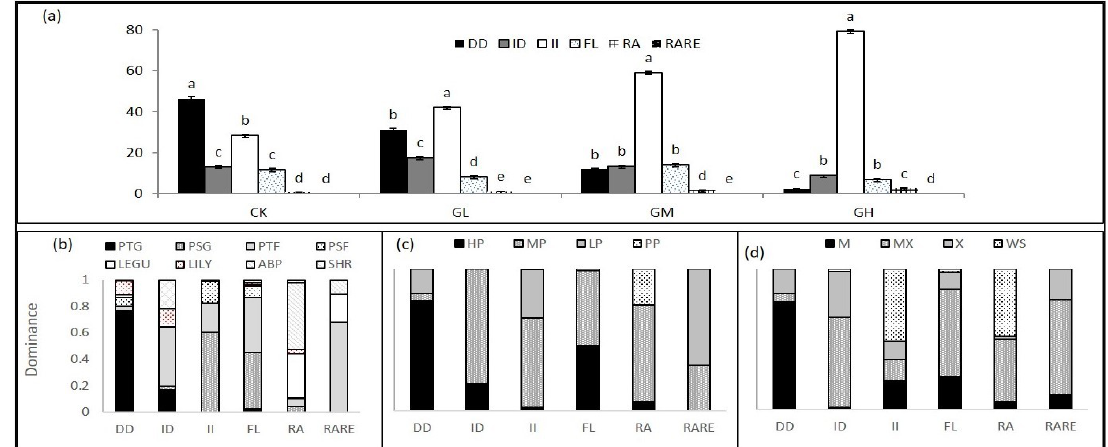
Figure A2. Species change pattern along grazing succession and their distribution in different functional groups, water ecotype and palatability level. Di ff erentlettersoverthebarsindicatesignificantdi ff erences at p < 0.05. ( a ) Changing pattern of species along di ff erent grazing intensity: DD—species dominance decreased along grazing gradient, ID— species dominance increased in light grazing and then declined in higher grazing intensity; II—species dominance increased along grazing gradient; FL—species dominance fluctuated stable; RA—species appeared randomly in community; RARE—species appeared only once in the research period; ( b – d ) are, respectively the dominance of di ff erent functional groups, palatability levels and water ecotypes with di ff erent succession changes. Data were calculating at peak biomass time (August) to determine the change in species pattern along grazing